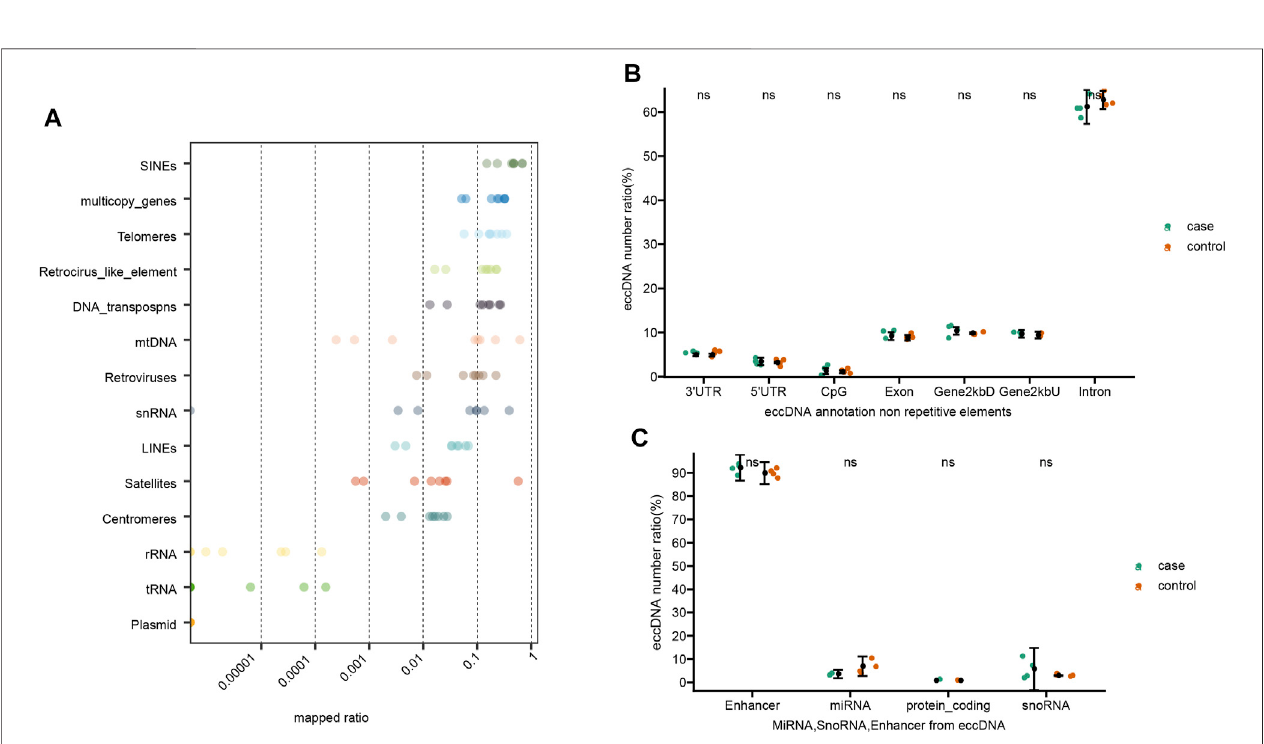
FIGURE 3 | Genomic elements of annotated eccDNAs. (A) EccDNA annotation on repetitive elements. (B) EccDNA annotation on non-repetitive elements. (C) MiRNA, SnoRNA, Enhancer from eccDNA. Ns stands for there are no signi fi cant differences of eccDNA distribution between control and gout group.